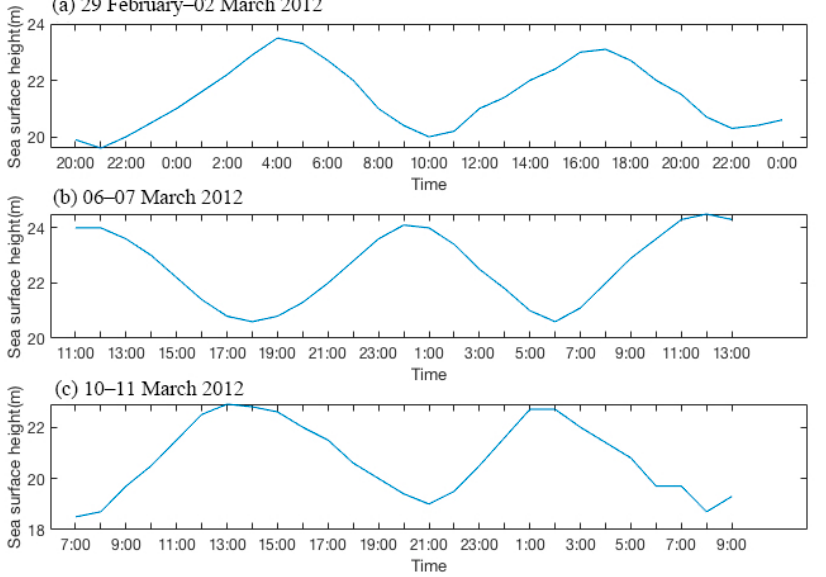
Table 4. In situ data.